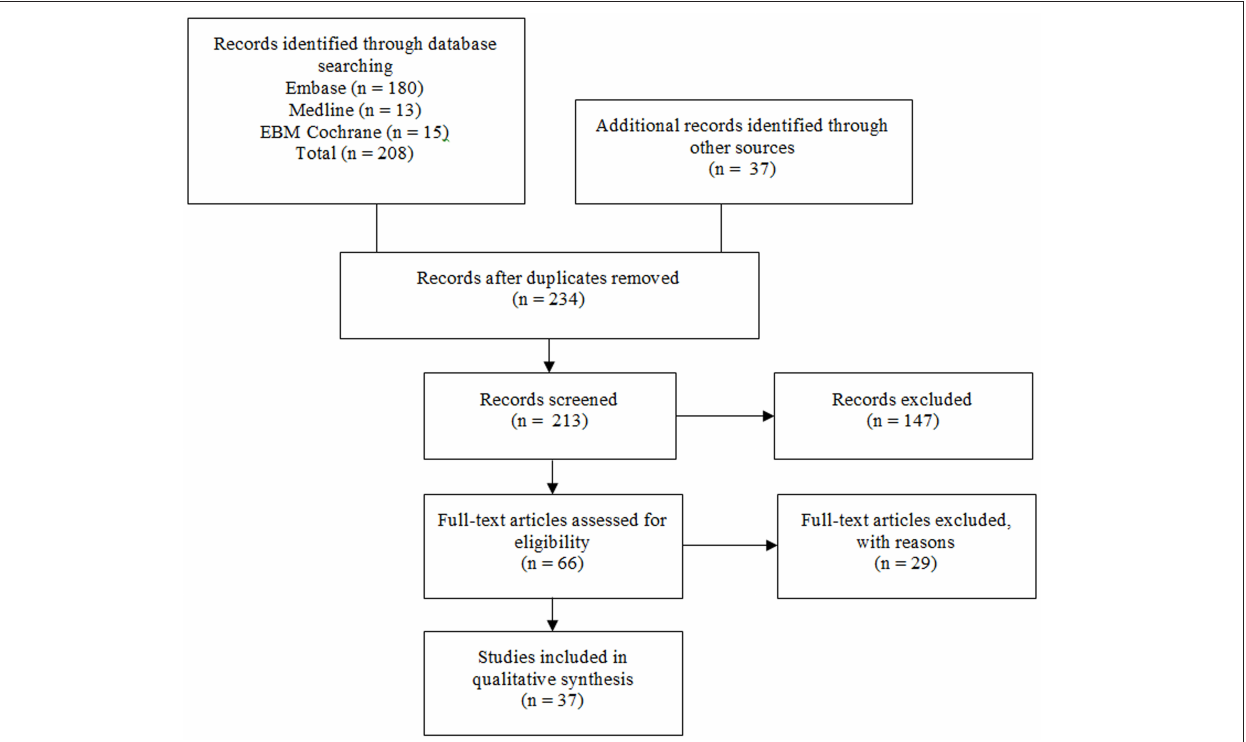
FIGURE 1 | Flow diagram for identification of studies. Original studies discussing clozapine, cardiovascular disease and autonomic function are reviewed. Keywords used: antipsychotic agents, antipsychotic drug*, antipsychotic*, schizophrenia, schizophren*, psychos*, psychotic*, mental ill*, mental disorder*, neuroleptic*, cardiovascular*, cardiovascular diseases, clozapine*, clozaril*, autonomic*, sympathetic*, catecholamine*, norepinephrine, noradrenaline, epinephrine, and